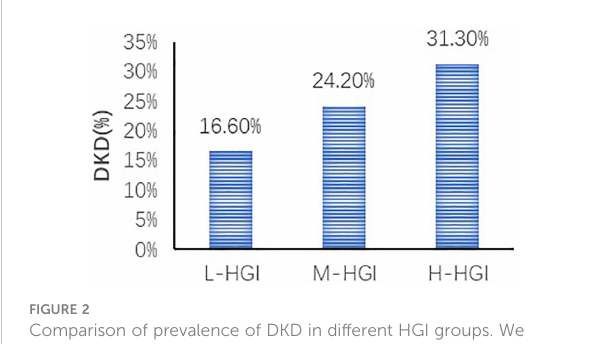
FIGURE 2 Comparison of prevalence of DKD in different HGI groups. We found an increase in the prevalence of DKD in three groups. The difference was statistically signi fi cant (P=0.000). Correlation analysis revealed that with the increase of HGI level the prevalence of DKD was increasing (r= 0.140, P=0.000).